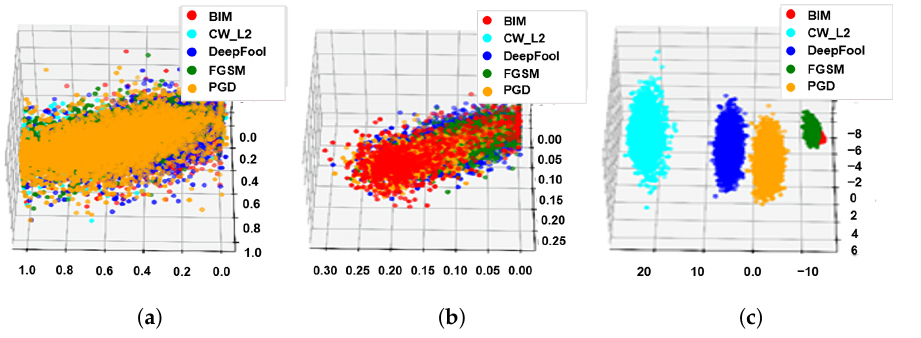
Figure 7. Visualized clustering results of the proposed method under the CIFAR-10 dataset. ( a ) Adversarial example + k-means (Step3). ( b ) Adversarial perturbation + k-means (Step 1 + Step 3). ( c ) Adversarial perturbation + LDA + k-means (Step 1 + Step 2 + Step